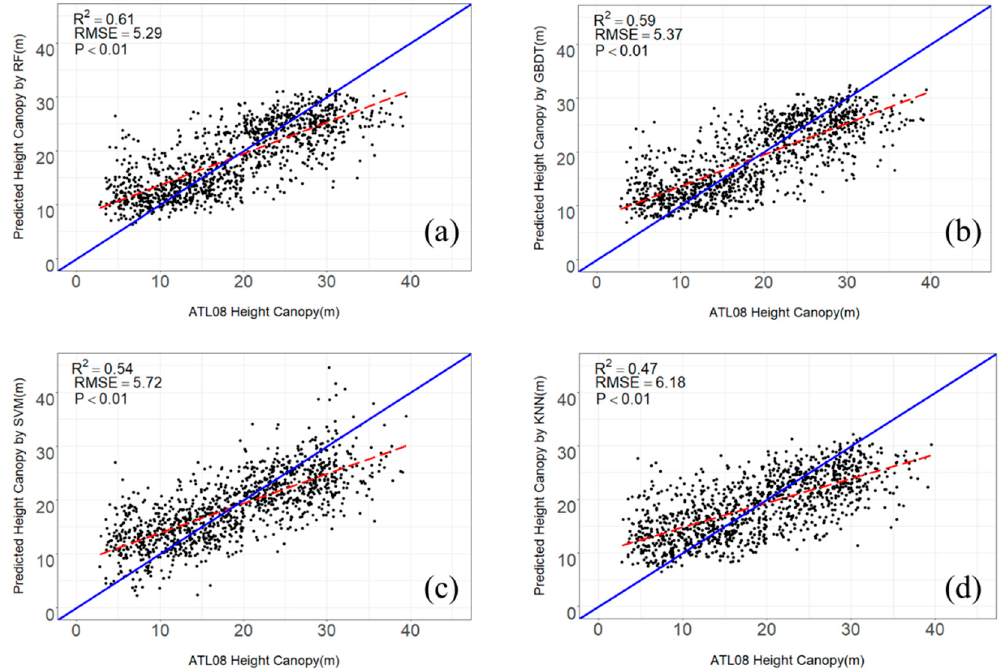
Figure 6. Comparison of accuracy of four machine learning models: ( a ) RF, ( b ) GBDT, ( c ) SVM, ( d ) KNN.